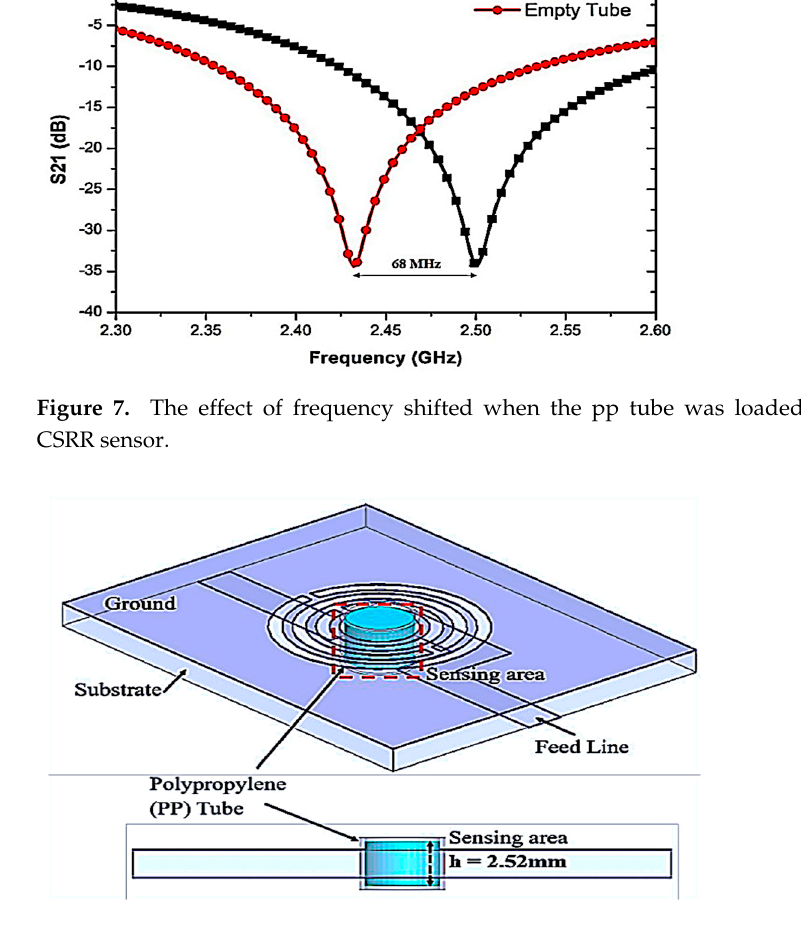
Figure 7. The effect of frequency shifted when the pp tube was loaded into the triple-rings CSRR sensor.